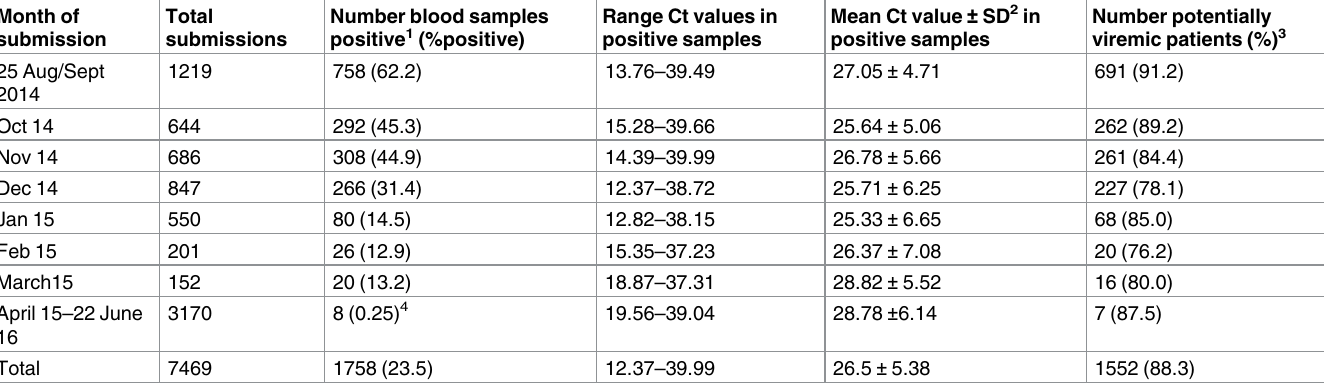
Table 1. Ebola virus polymerase gene TaqMan real-time RT-PCR results in blood